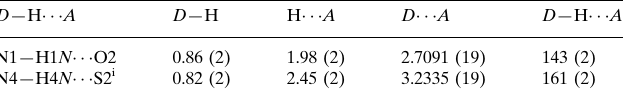
Hydrogen-bond geometry (A˚ , (cid:3)